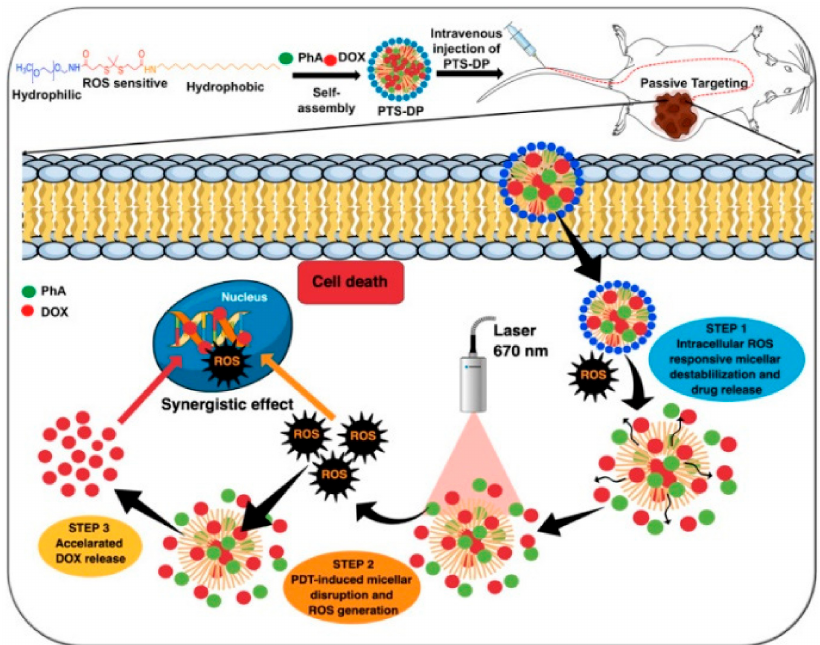
Figure 15. Preparation of PTS-DP nanomicelles and their DOX loaded and release strategy under ROS trigger for enhanced chemo-photodynamic therapy. Reprinted with permission from [221]. Copyright © 2020, Elsevier.